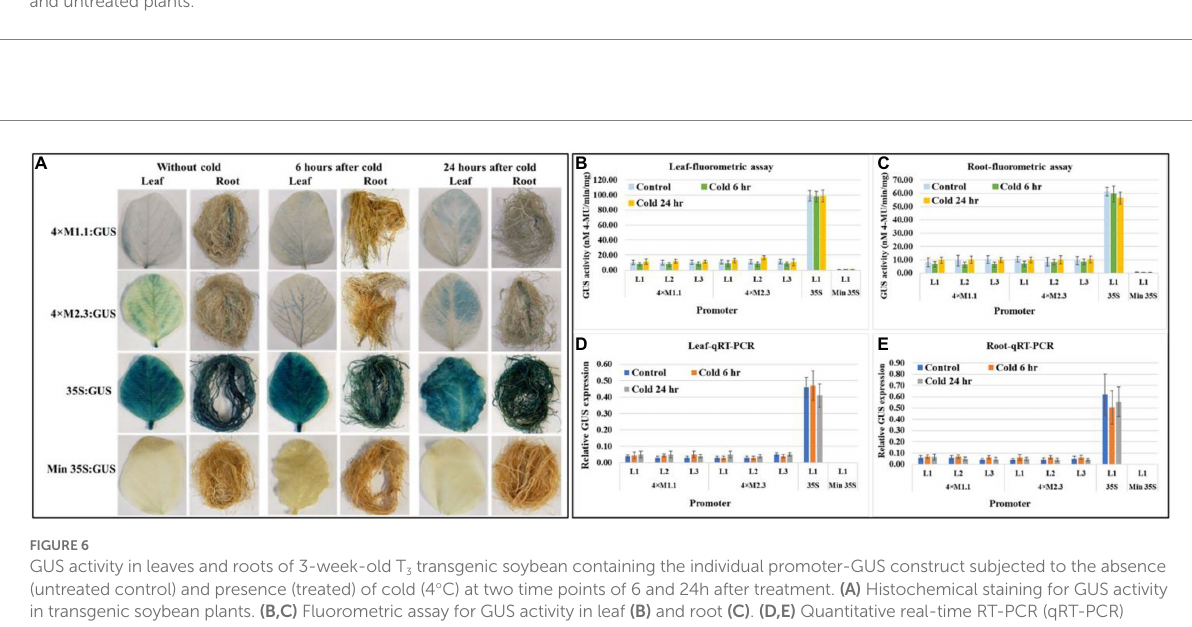
the 4 × M1.1 promoter and an average of 2.7-fold higher under the control of the 4 × M2.3 promoter (Supplementary Figure S5B). The qRT-PCR GUS expression levels in the leaves were also consistent with the results of the fluorometric GUS assay (Supplementary Figure S5D).